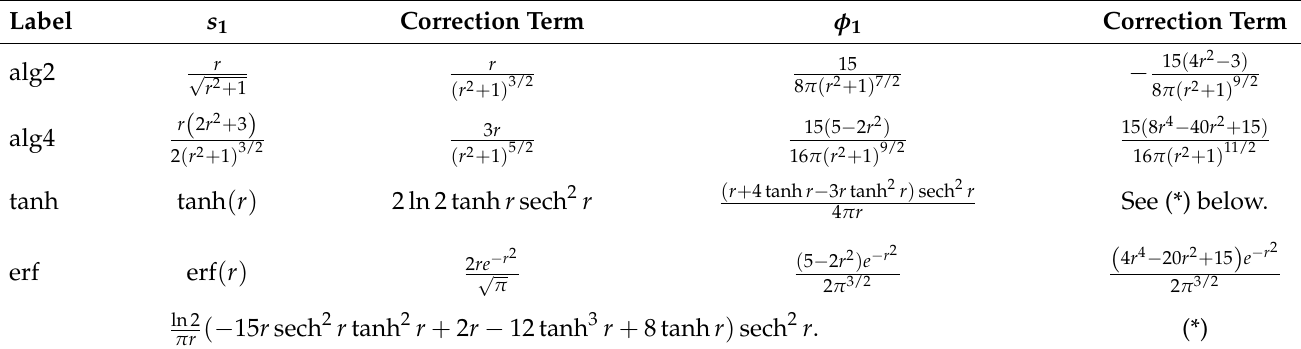
Table 1. Radially symmetric smoothing factors s 1 in use in (17) and their corresponding blob